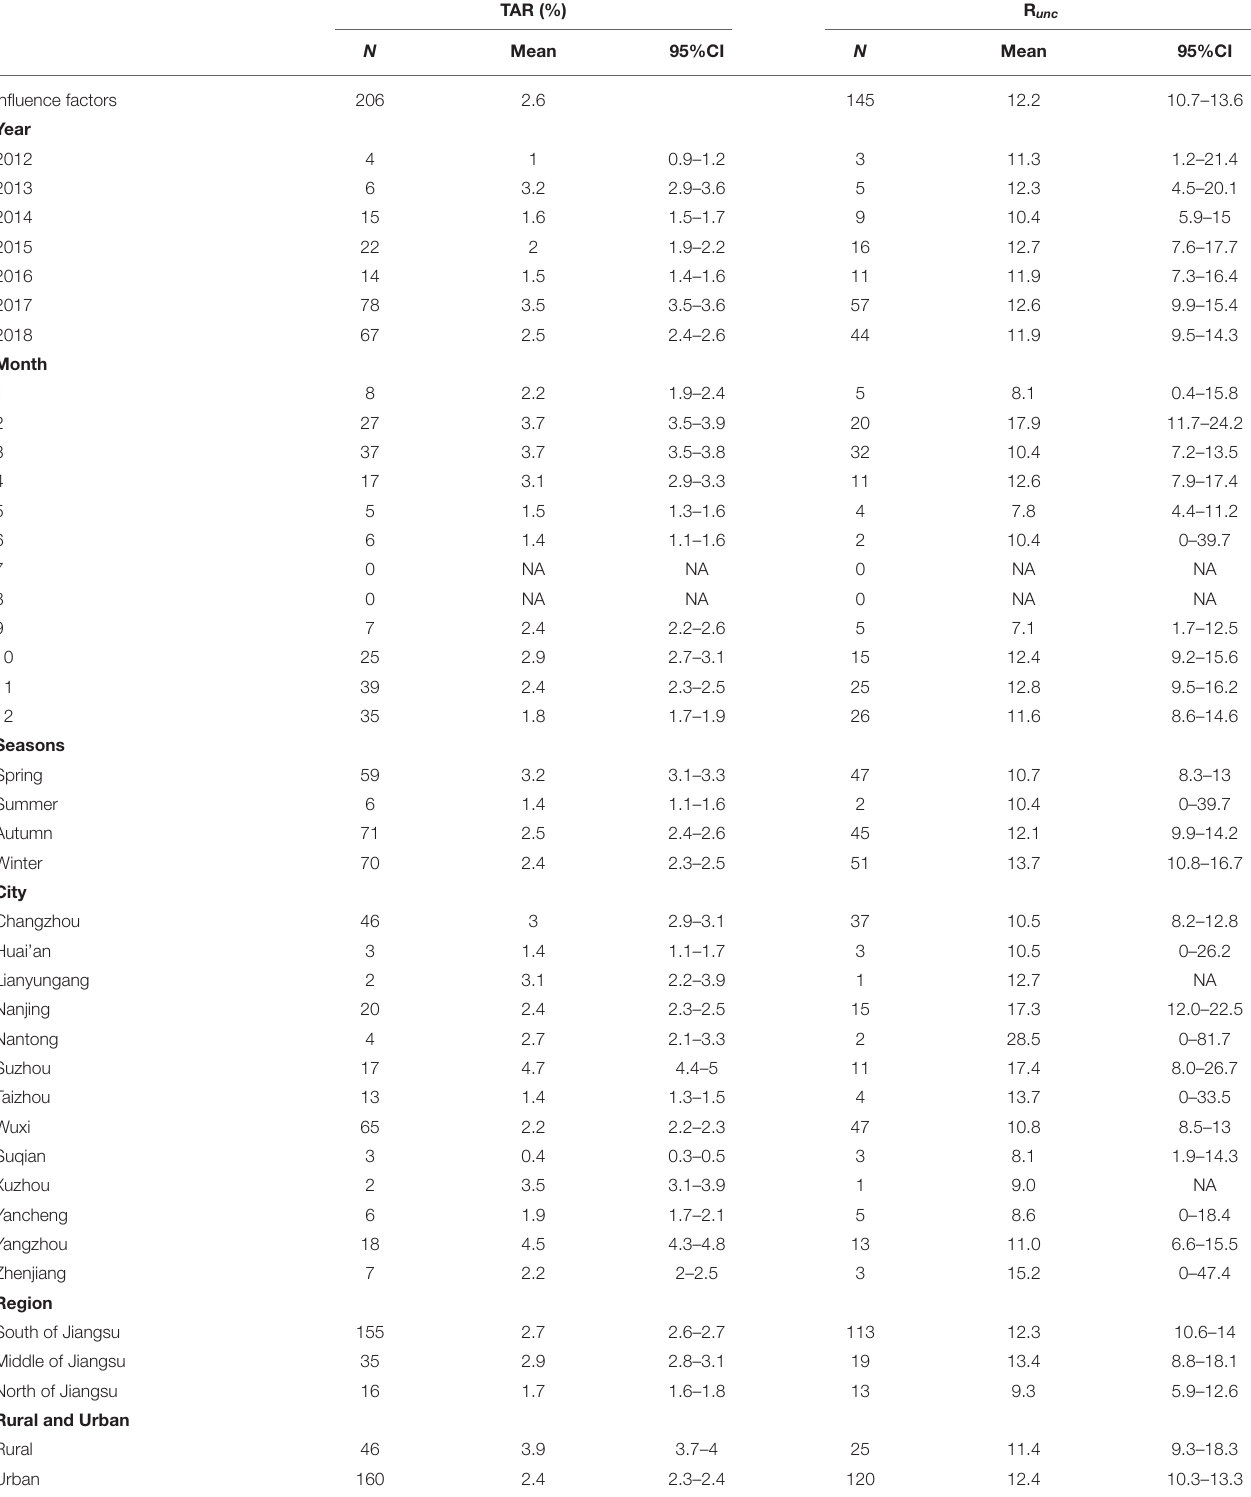
TABLE 2 | TAR and transmissibility and influence factors in 206 outbreaks of norovirus in Jiangsu